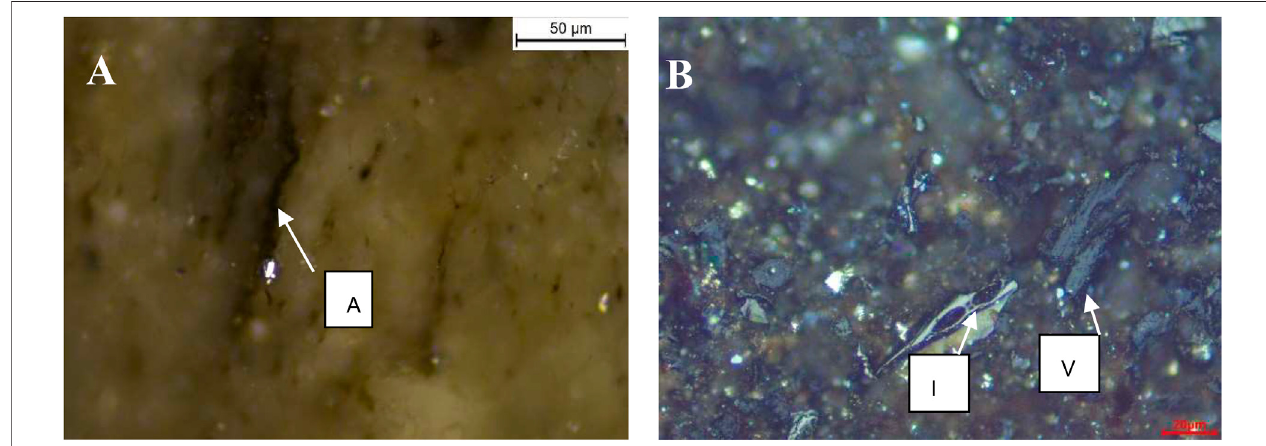
FIGURE 4 | Organic petrography photomicrographs (oil immersion, white incident light) (A) showing typical maceral of alginite in NAS 472-RD (B) showing some vitrinite and inertinite maceral presence in Yabulai Shale. Abbreviations: V – vitrinite, A – alginite, I – inertinite.